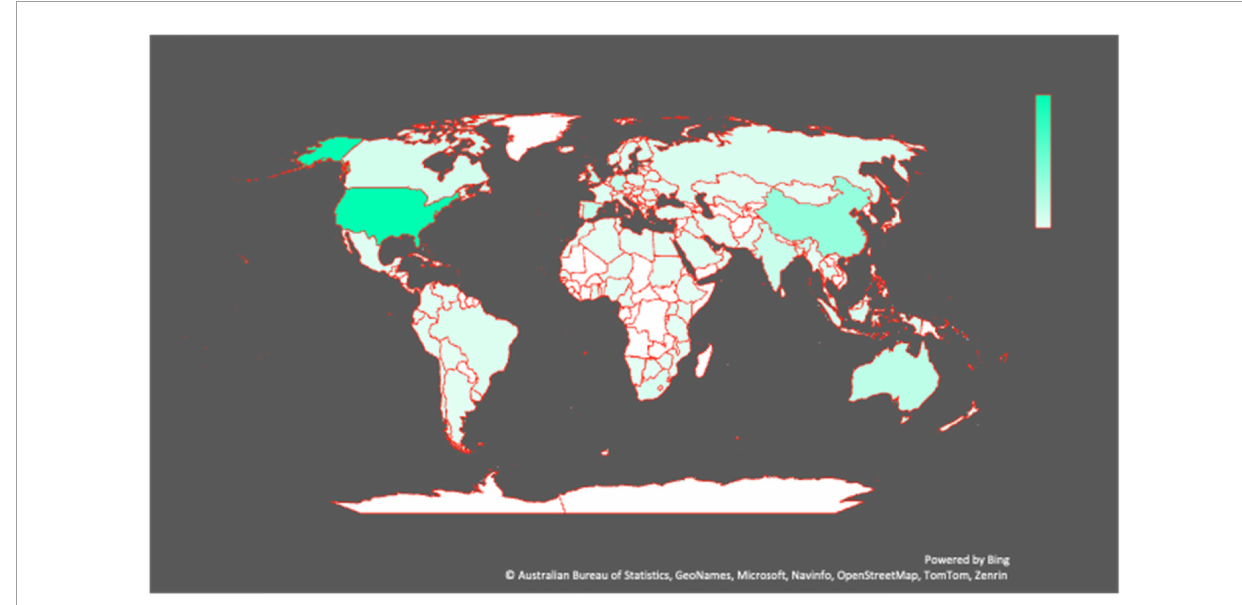
FIGURE9 Global map representing efforts by countries toward the adaptation of online learning-based E.D. 4.0 environment.